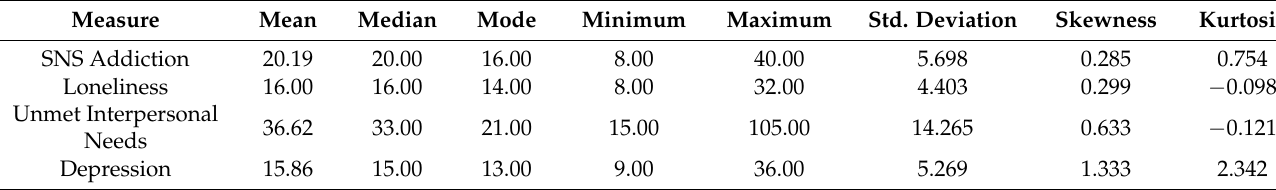
Table 2. Descriptive statistics for variables.